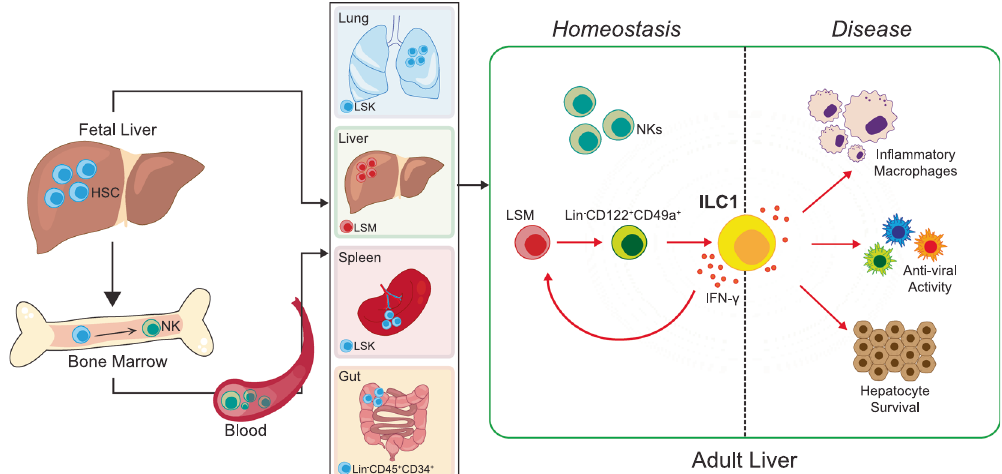
Fig. 1 IFN- γ – regulates local development of type 1 innate lymphoid cells (ILC1s) and protects the liver from disease. Lin − Sca-1 + Mac-1 + (LSM) hematopoietic stem cells in the adult liver derived from the fetal liver, give rise to Lin - CD122 + CD49a + cells acting as a precursor